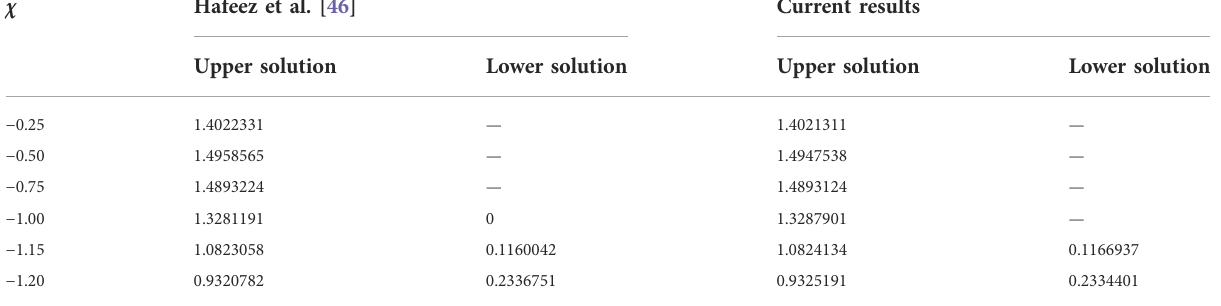
TABLE 2 Comparison of Re 1 2 C fx for distant values of χ